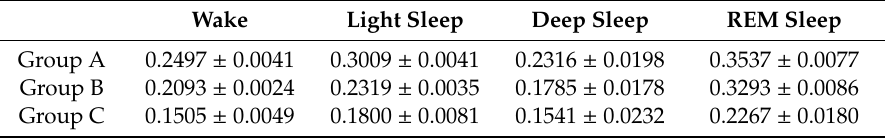
Table 2. Mean Values ± Variance of Switching Rate in Three Groups.